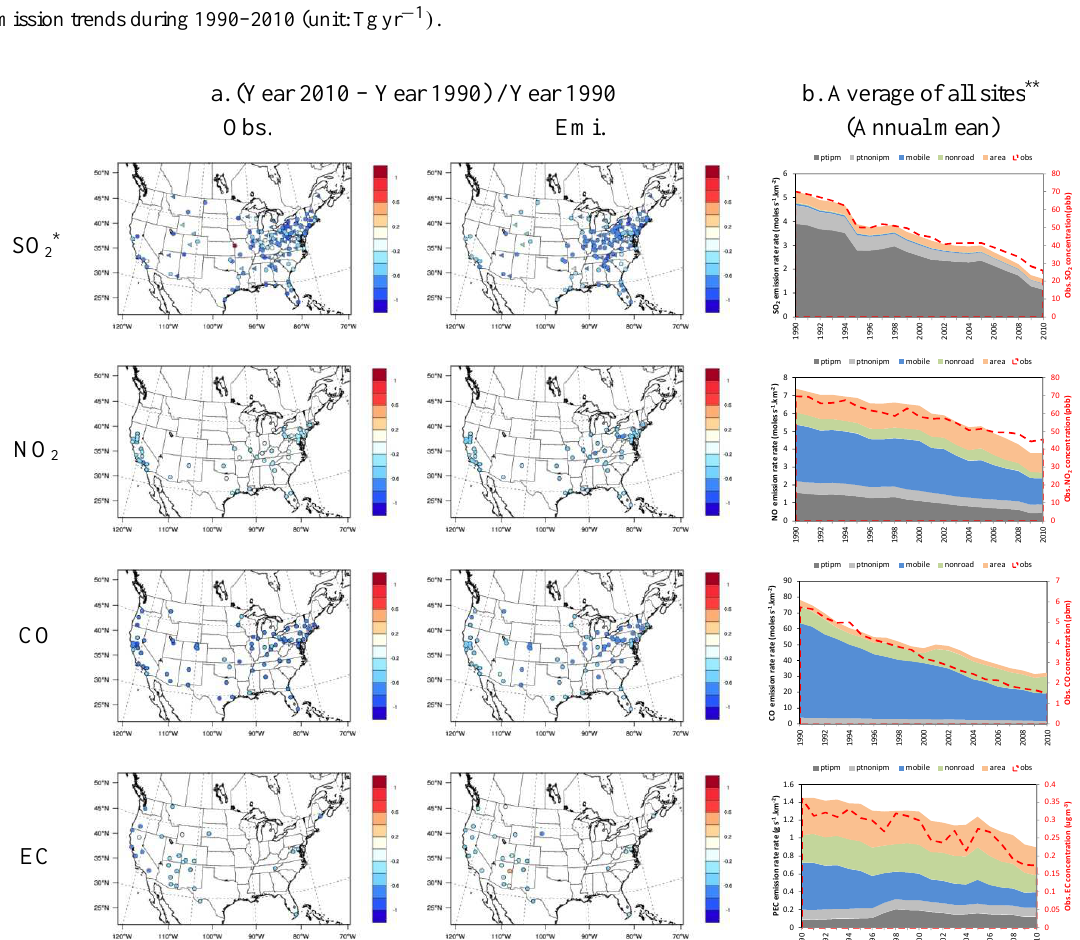
Fig. 10. Comparison of historic trends between emissions and observed concentration from 1990 to 2010 (* for SO 2 , circles represent AQS sites; triangles represent CASTNET sites; ∗∗ SMOKE sectors include (1) ptipm – NEI point source EGUs mapped to the Integrated Planning Model using the National Electric Energy Database System; (2) ptnonipm – all NEI point source records not matched to the ptipm sector; (3) mobile; (4) non-road and (5) other area sources.)